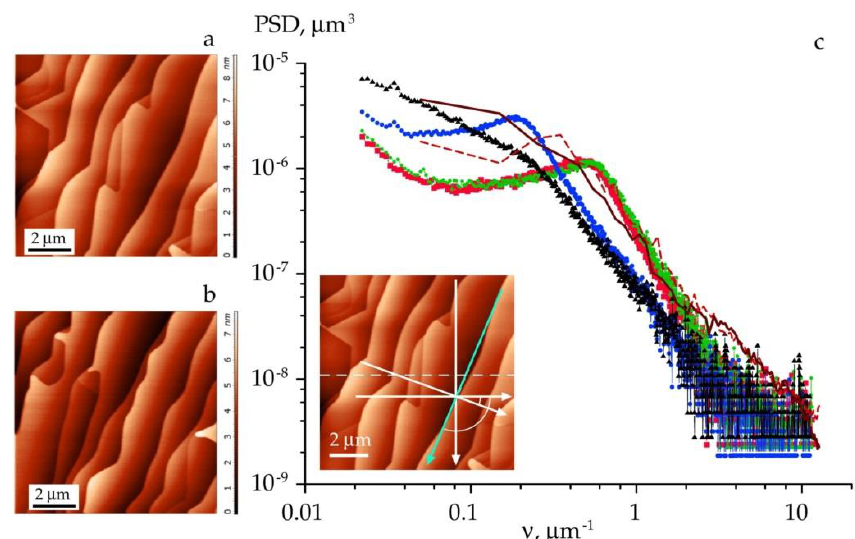
Figure 4. AFM images ( a , b ) and roughness PSD functions vs. spatial frequency ( c ) calculated for the surface of the annealed specimen (1450 °C). In the inset figure within ( c ) the dotted line indicates the initial AFM scan. The PSD functions along probing directions, which deviate 0°, −20°, −90° and −110° from the initial scan line, are represented with red, green, blue and black markers, respectively. Arcs mark angles of −20° and −110°. The cyan arrow shows the probing direction along a terrace edge. Brown lines depict the PSD functions extracted from AFM data. In particular, the solid brown line corresponds to the cyan arrow.